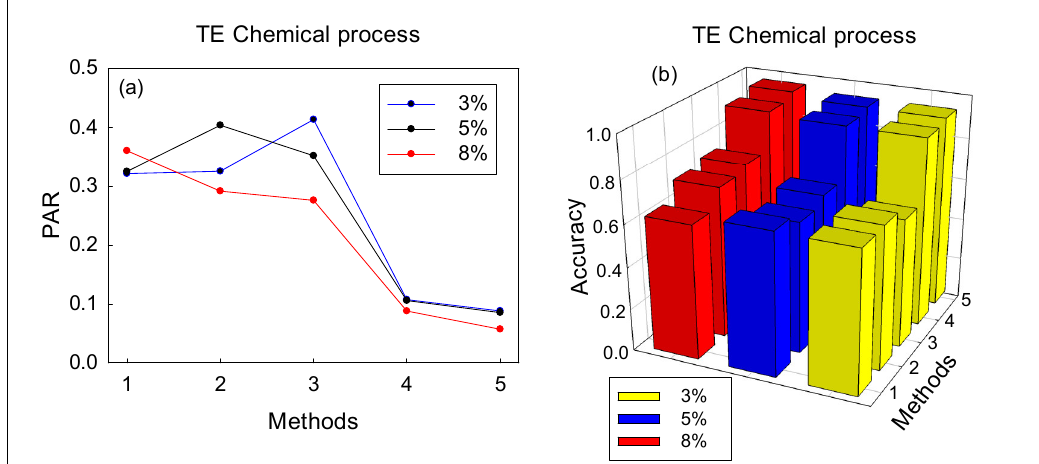
Figure 4. Average of comprehensive key performance indicators (KPIs) based on the proposed method and four other methods: ( a ) pre-alarm rate (PAR); ( b ) accuracy.